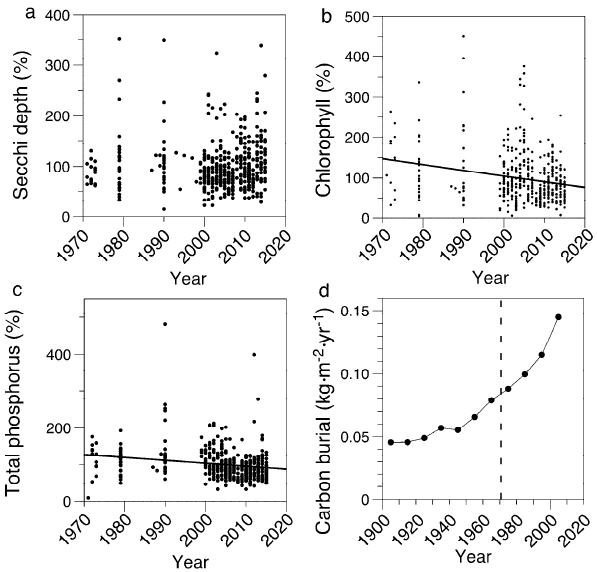
Figure 3. Composite plot of Secchi disk depths for the 24 Iowa lakes with field measurements expressed as per cents of the lake average versus year of sampling ( a ). The same kind of plots showing statistically significant slopes of chlorophyll (( b ) R 2 = 0.05, p < 0.0001) and total phosphorus (( c ) R 2 = 0.05, p < 0.0001) Decadal geometric averages for rates of carbon burial based on 210 Pb dating of sediment cores from 33 Iowa lakes using data from Heathcote et al. [11] ( d ). The vertical dashed line indicates the year 1971 to identify the period with field measurements. · ·